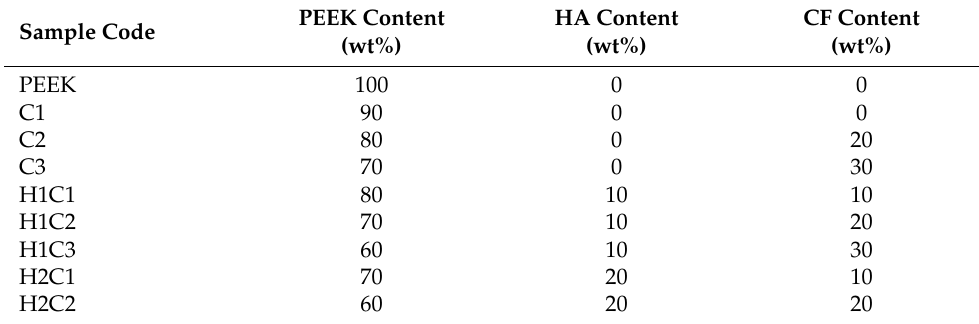
Table 2. Formulation ratios of the PEEK composites.